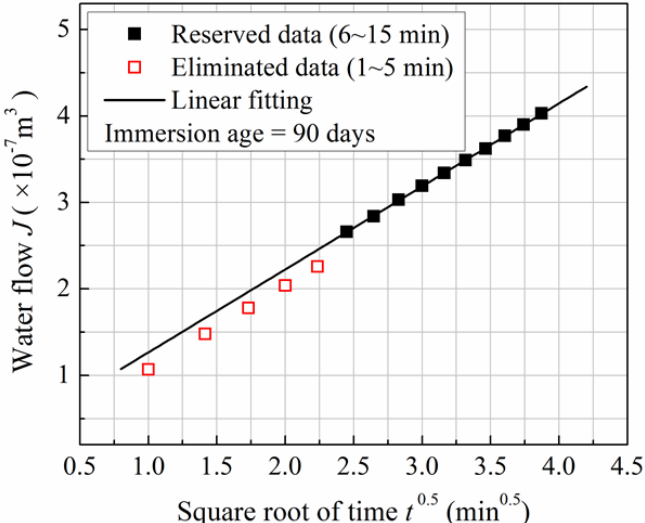
Figure 1. An arbitrary example of the processing of Autoclam test